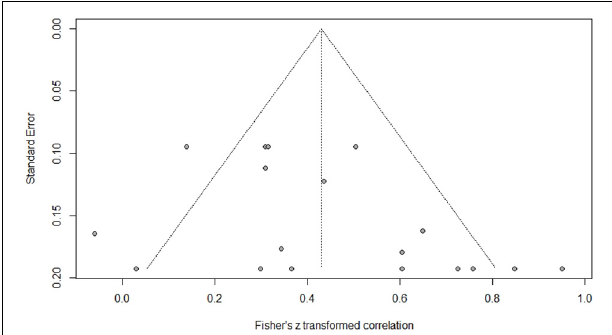
FIGURE 3 | Funnel plot of effect sizes vs. standard error for phonological awareness and Chinese word